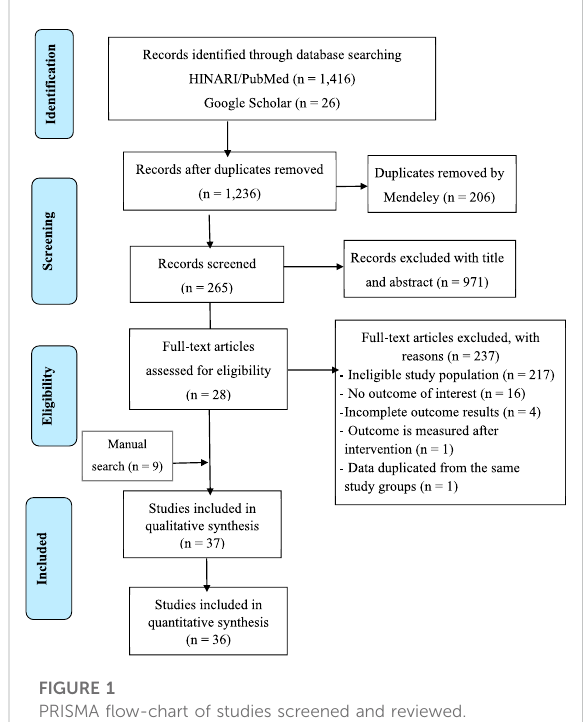
FIGURE 1 PRISMA fl ow-chart of studies screened and